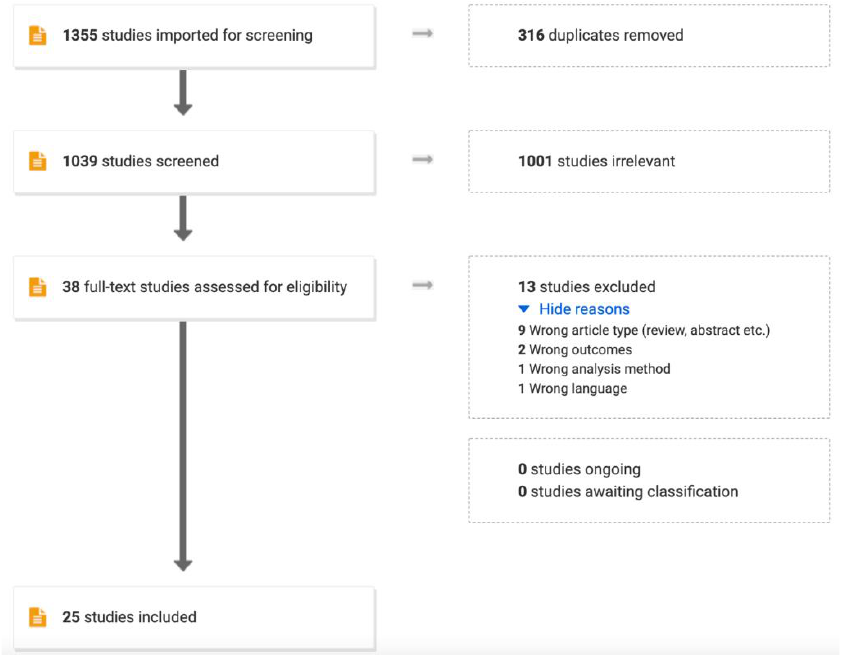
Figure 1. PRISMA flowchart illustrating the process from screening to inclusion of the studies for the review.